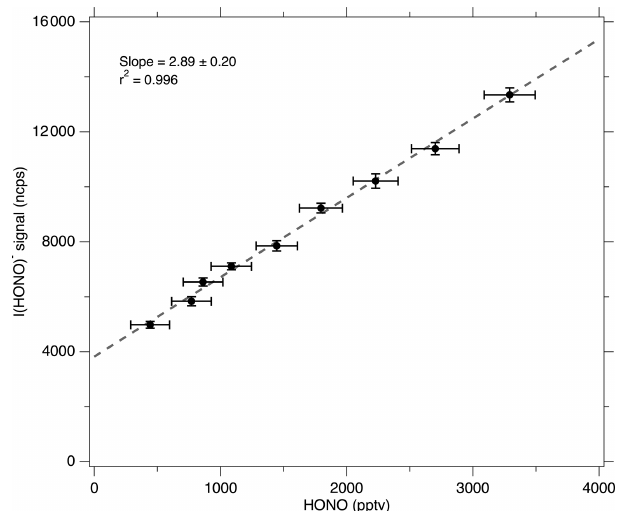
Figure 2. The 1s averaged time series data for a proxy calibration at a constant relative humidity. The iodide HONO adduct signal (cps) is shown normalized per 1 million reagent ions (ncps). The shaded section represents the period in which the 184.9nm mercury lamp is toggled off to obtain background [NO 2 ] and HONO signal. The NO 2 concentration is shown with an offset so that background val- ues are near 0ppbv. The resulting difference in NO 2 indicates that approximately 3000pptv [HONO] is sampled by the CIMS.